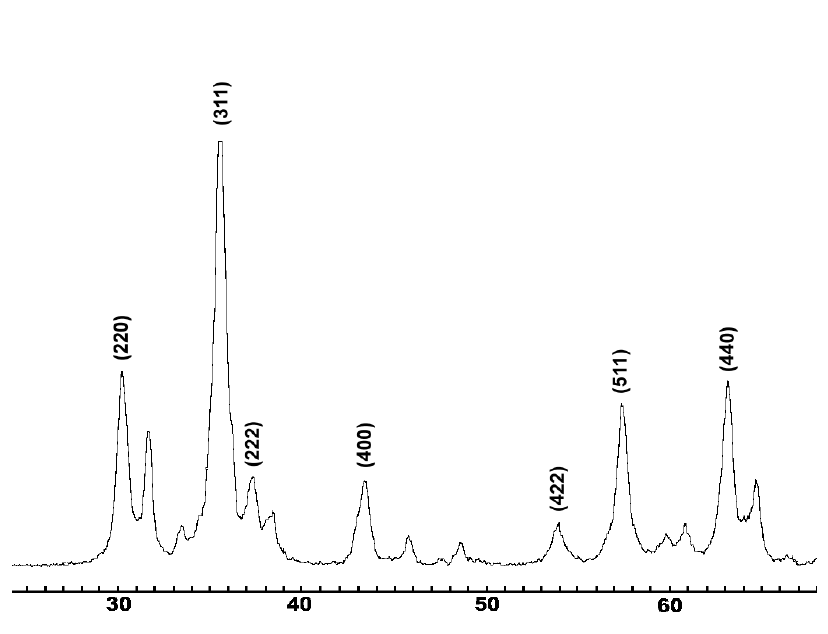
Figure 2(a) prepared by coprecipitation.